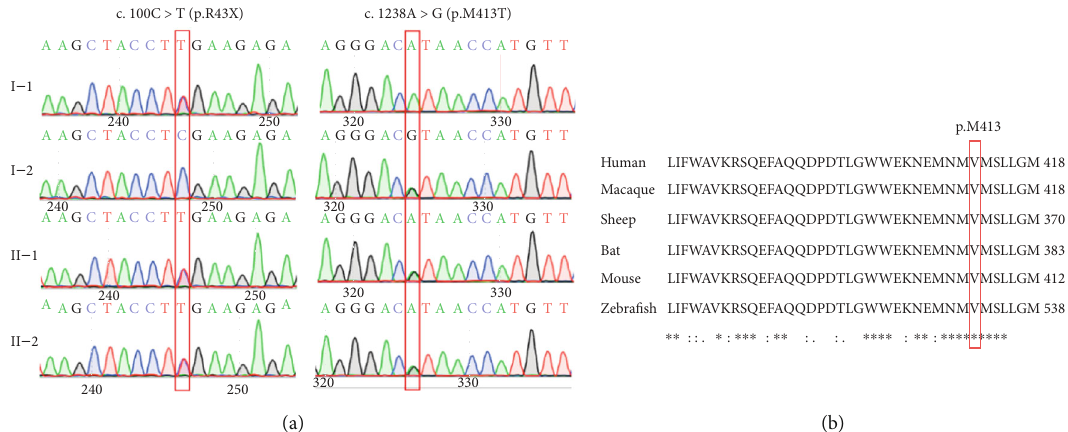
Figure 3: (a) The Sanger sequencing results of the p.R34X and p.M413T mutations in TMC1 in Family 1. (b) Multispecies sequence alignment of the M413